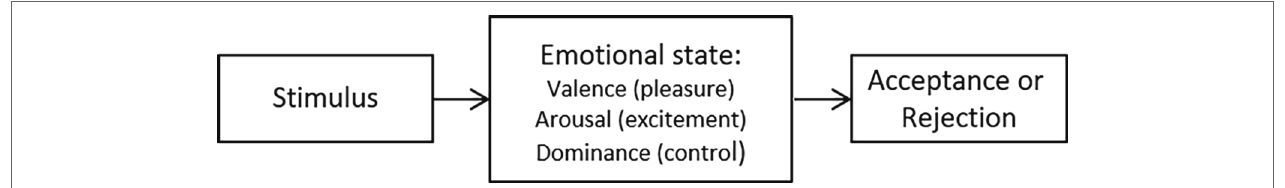
FIGURE 1 | PAD model. Source: Mehrabian and Russell